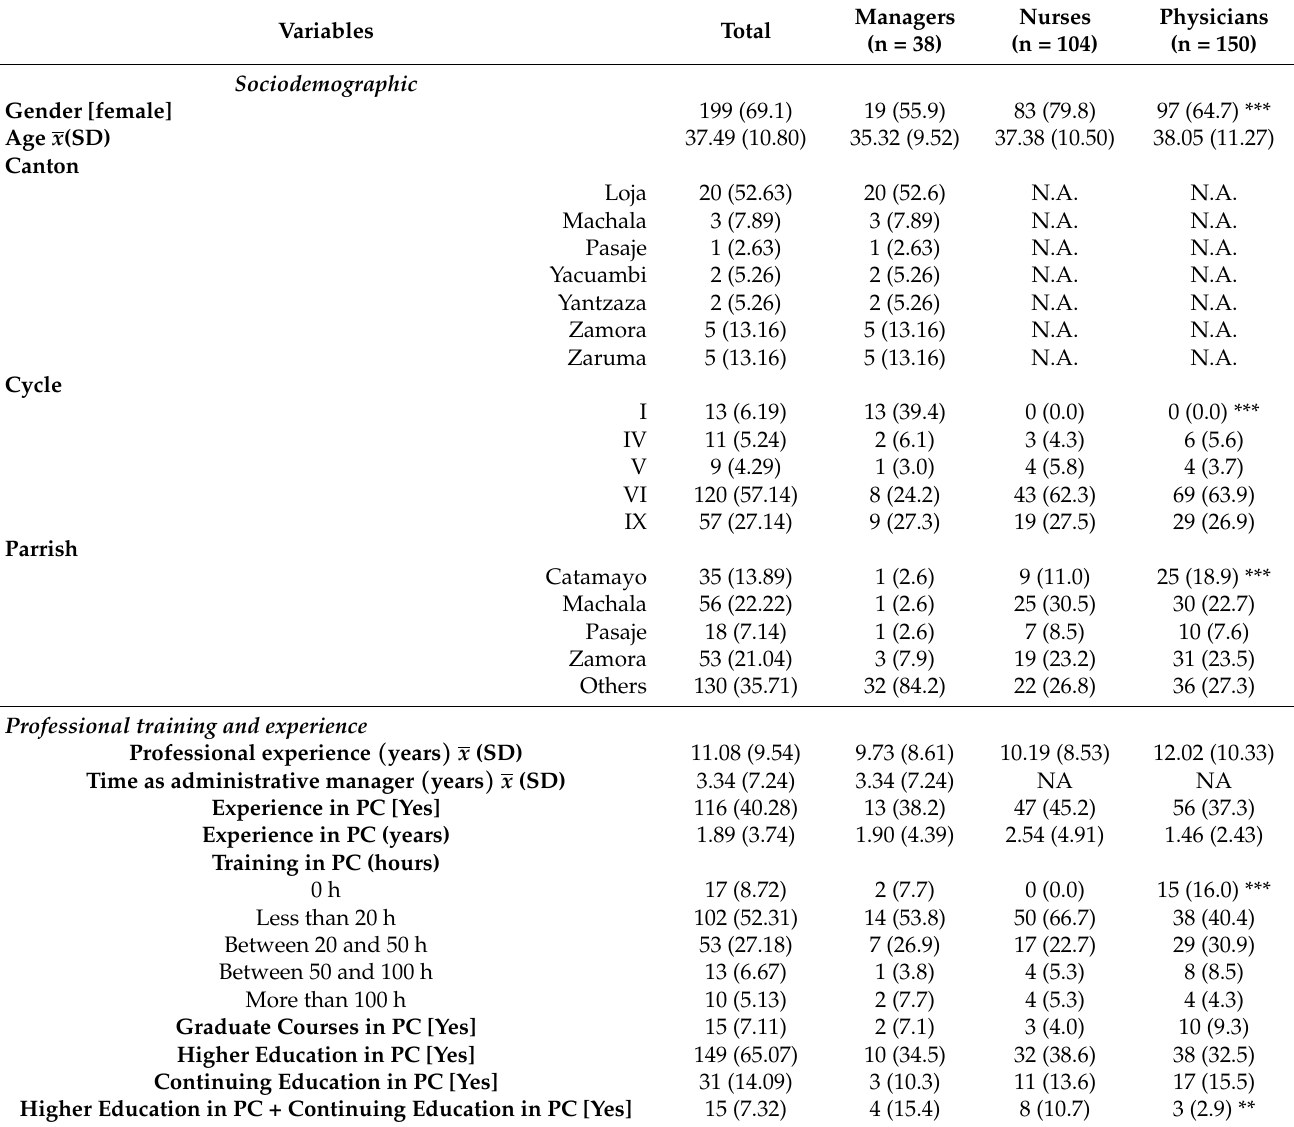
Table 1. Characteristics of the sample (n =